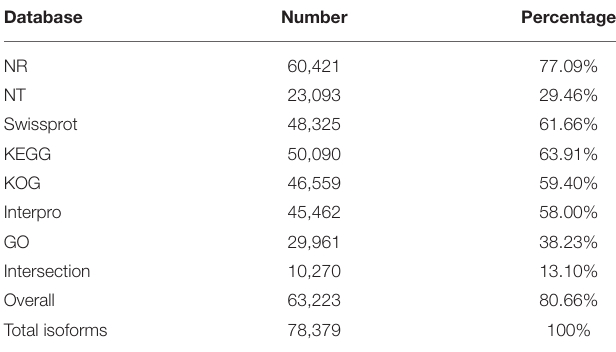
TABLE 2 | Annotation